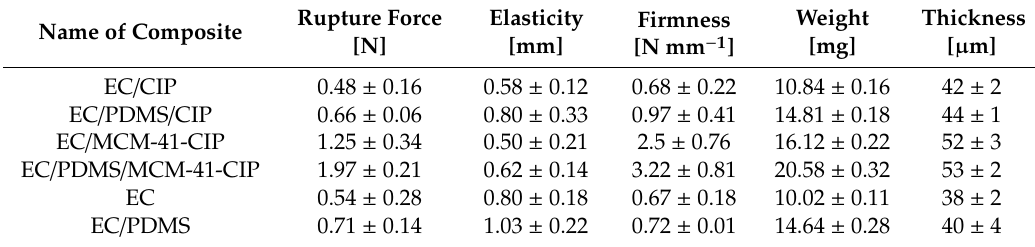
Table 2. The rupture force, elasticity, and firmness of obtained composites EC / CIP, EC / PDMS /